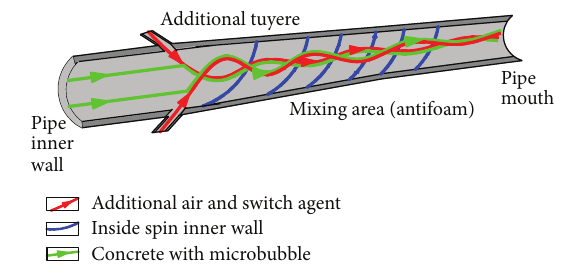
Figure 8: The scheme of mixing process of switch agent and foam